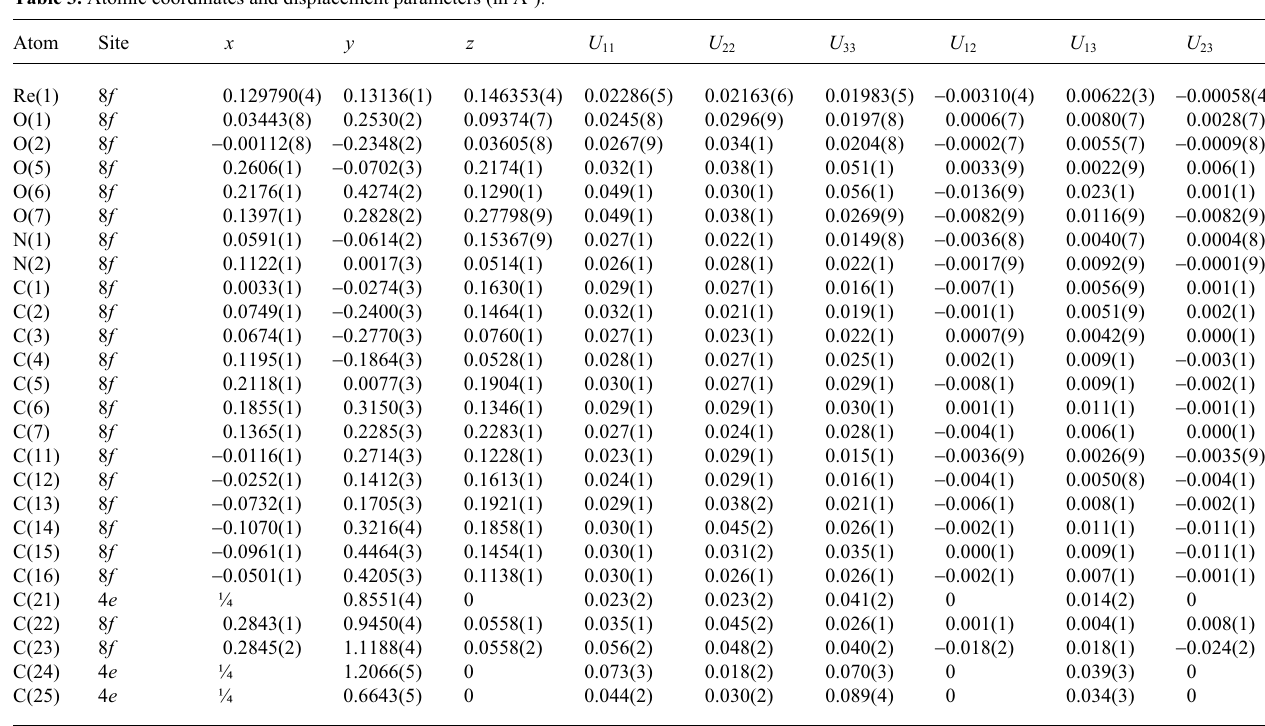
Table 3. Atomic coordinates and displacement parameters (in Å 2 )